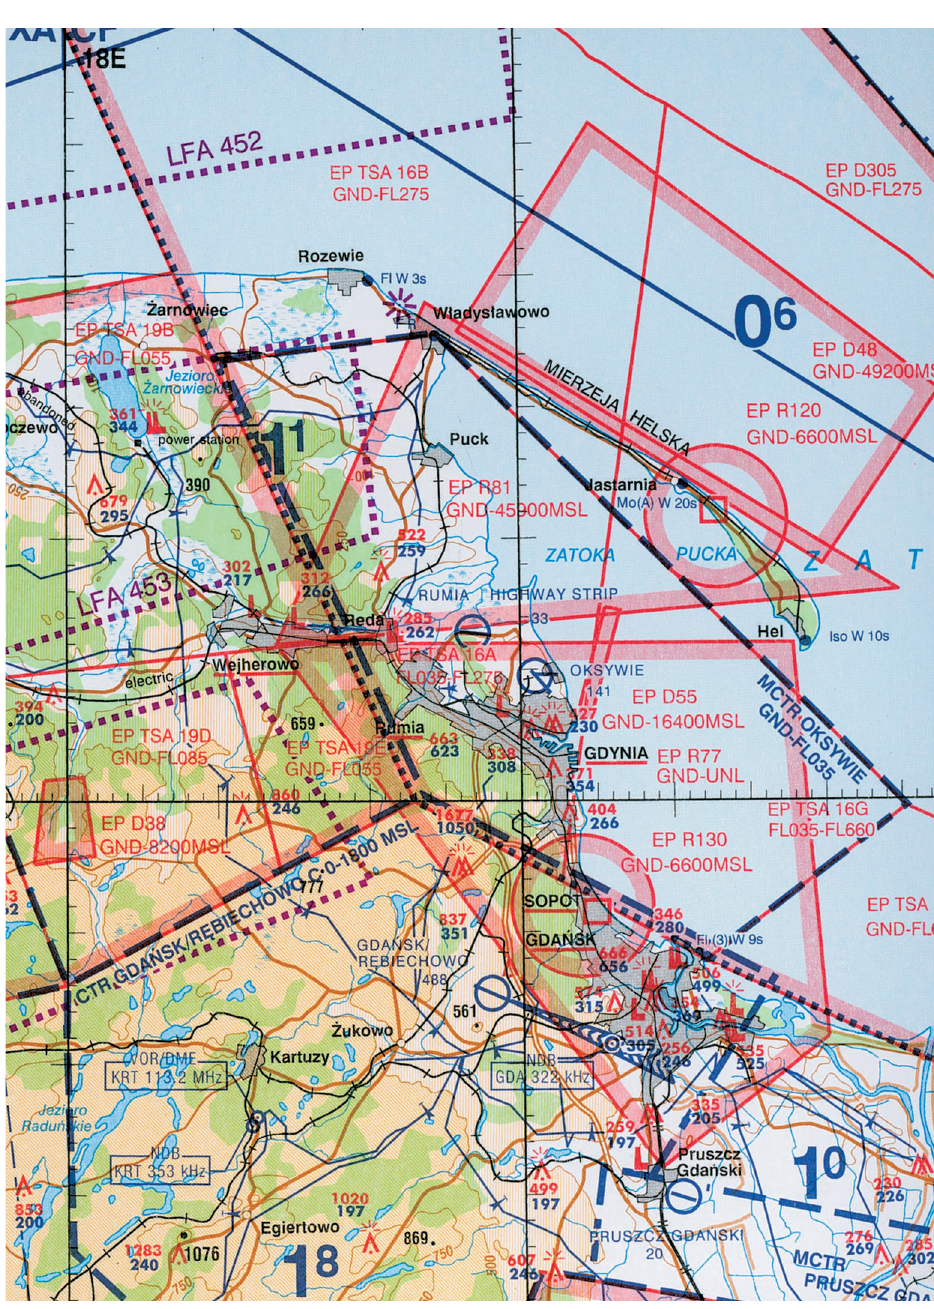
Fig. 17. Low Flying Chart , 1:500,000 – LFC-Europe